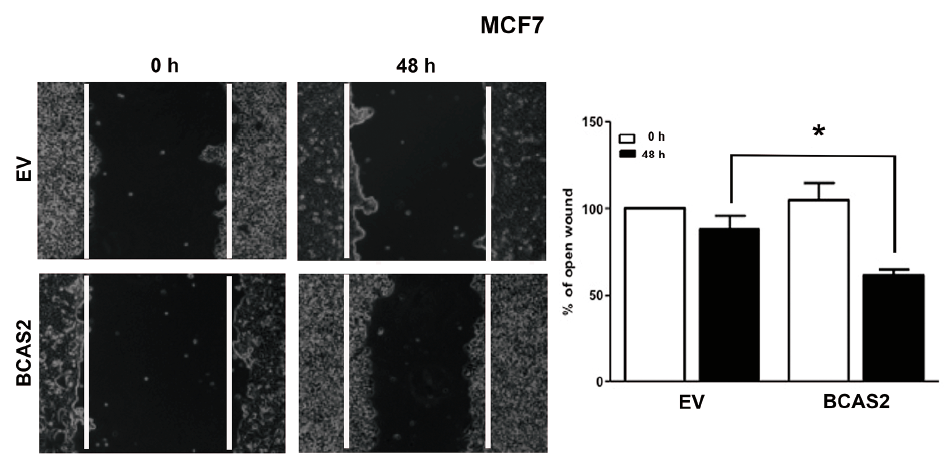
Figure 6. BCAS2 significantly increases cell migration. The effect of BCAS2 overexpression on MCF7 cell migration was determined using a wound healing assay. The wound healing rate of BCAS2 transfected cells was faster than empty vector (EV) in presence of E2. The open wound area at 0h was regarded as 100%. Values represent mean ± SD of three replicates. * p < 0.05 compared to the EV group at 48 h of E2 treatment. 10× magnification.